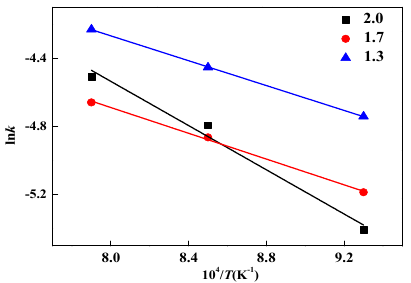
Figure 13. E ff ect of reduction degree on activation energy. Figure 13. Effect of reduction degree on activation energy. Table 6. Activation energy and pre-exponential factor of di ff erent Table 6. Activation energy and pre-exponential factor of different sinter.